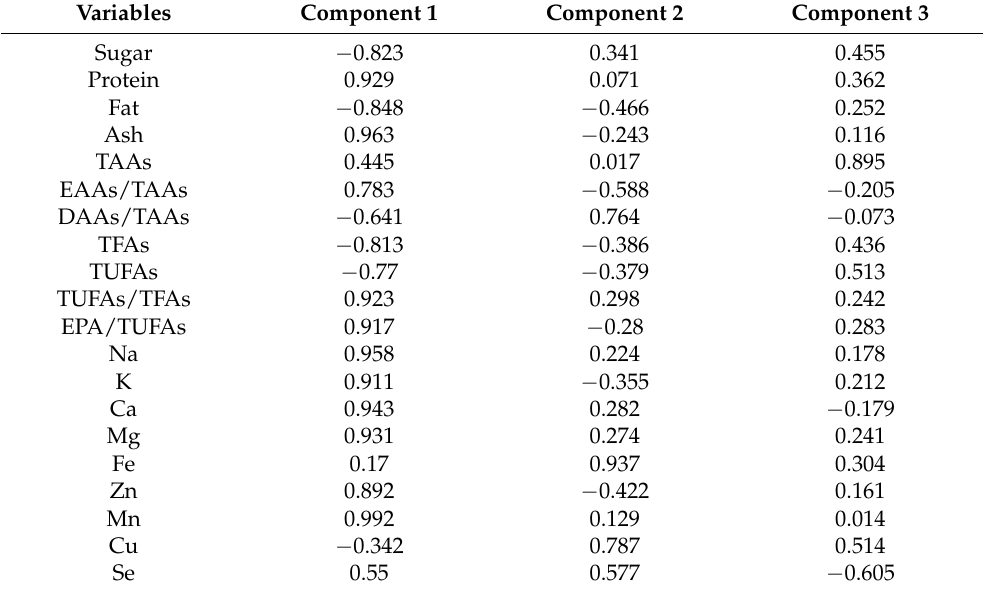
Table 5. Factor-loading matrix for the three principal components. The abbreviations were the same in Table